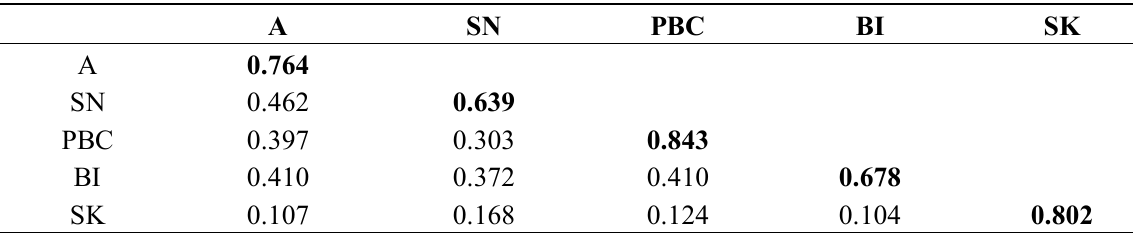
Table 3. Discriminant